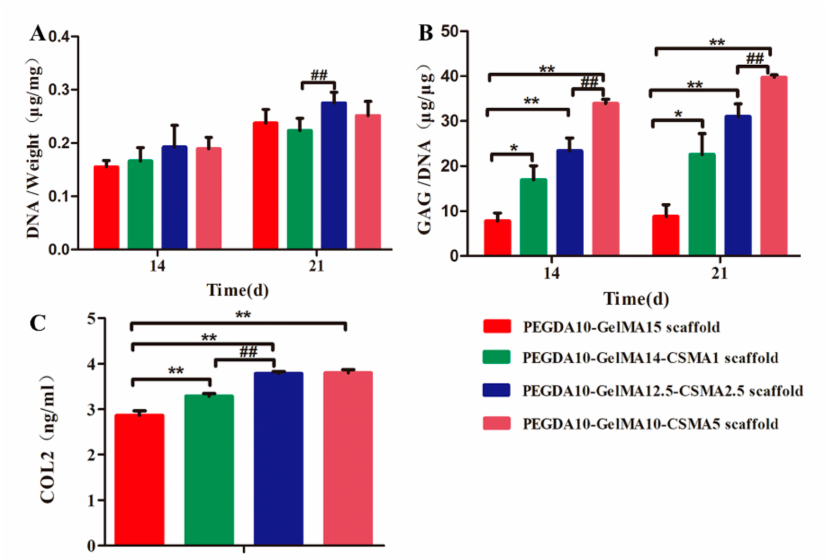
Figure 7. DNA contents, GAG production, and COL2 proteins in different types of PEGDA-GelMA- CSMA scaffolds on day 14 and day 21 culture. ( A ) DNA contents, ( B ) GAG production, and ( C ) COL2 deposition on four scaffolds by the BMSCs ( n = 3; * p < 0.05, ** p < 0.01, ## p <